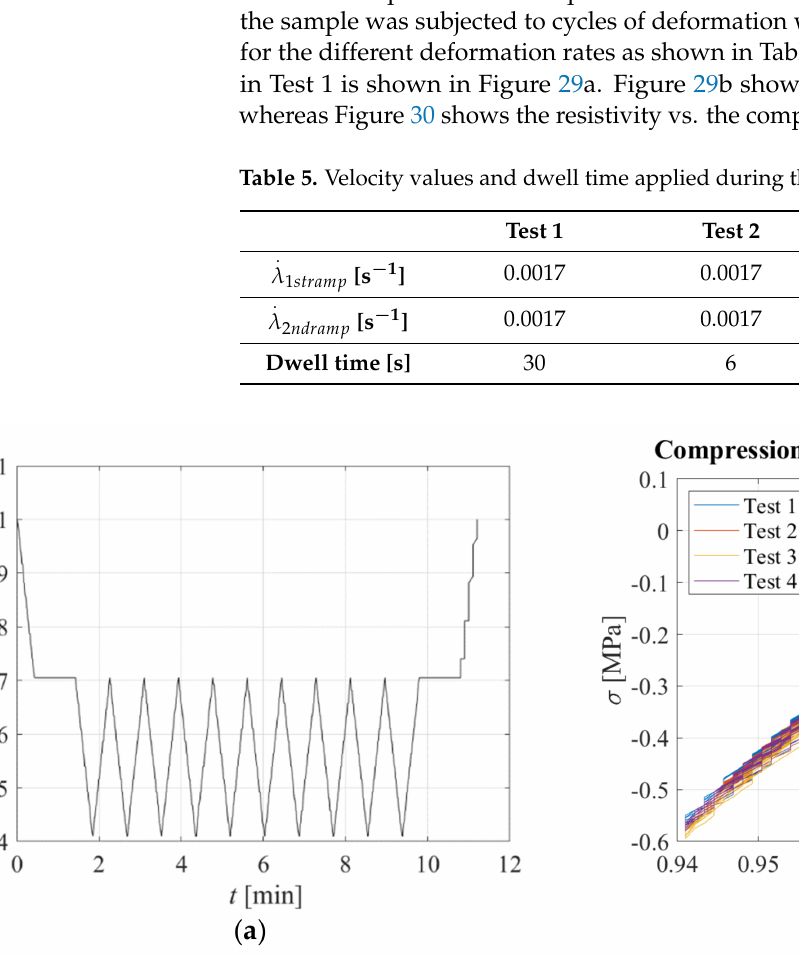
Figure 28. Resistivity vs. compression ratio during 3 cycles. Specimen with l 0 / d 0 = 0.17. Another test was performed on the same sample. It was compressed up to λ = 0.97,